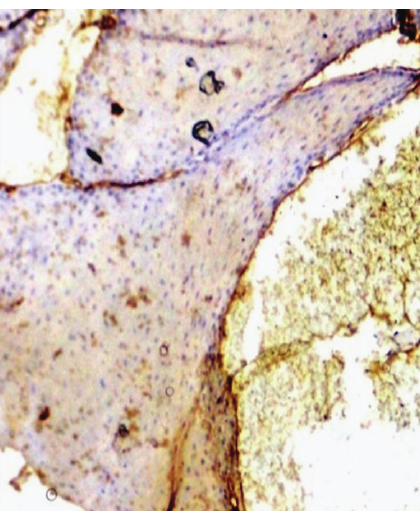
Figure 5: Immunohistochemical profile of the lesion with expres- sion CD34